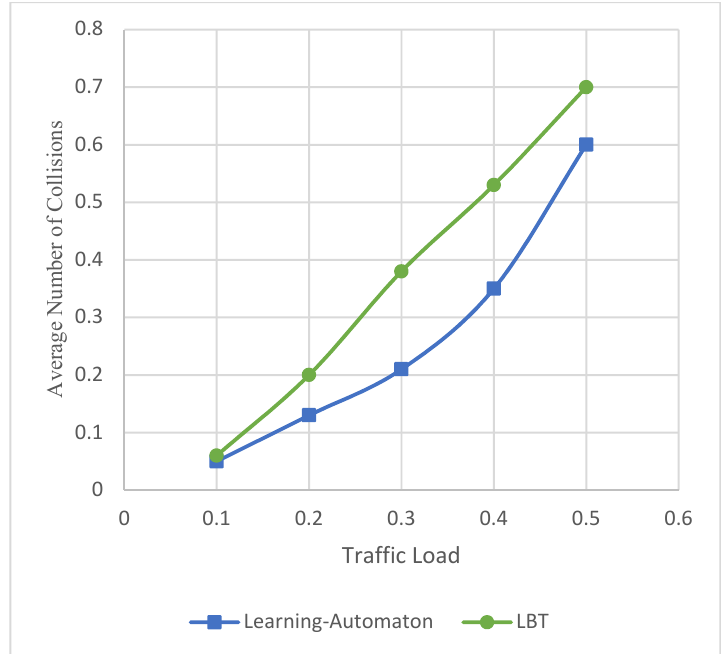
Figure 6. Average collisions versus traffic load.